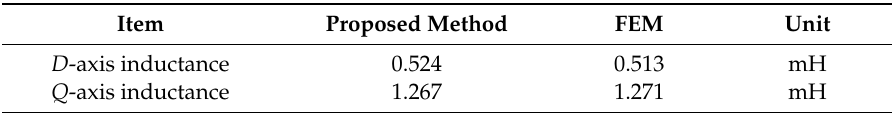
Table 3. The inductances of the two